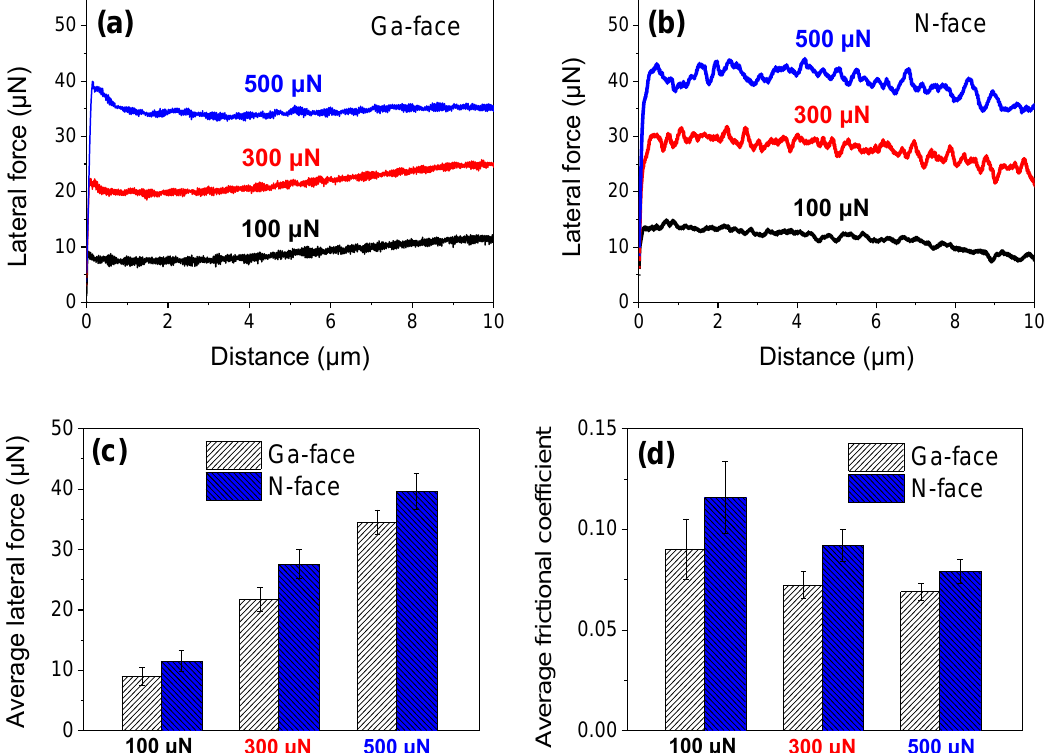
Figure 6. Comparison of the lateral force on Ga- and N-faced GaN samples under different constant normal loads of 100 µ N, 300 µ N, and 500 µ N, respectively. ( a ) Lateral force vs. scratching distance of the Ga-faced sample. ( b ) Lateral force vs. scratching distance of the N-faced sample. ( c ) Comparison of the average lateral forces of the Ga- and N-faced GaN samples under different constant normal loads. ( d ) Comparison of the average frictional coefficients of the Ga- and N-faced GaN samples under different constant normal loads.